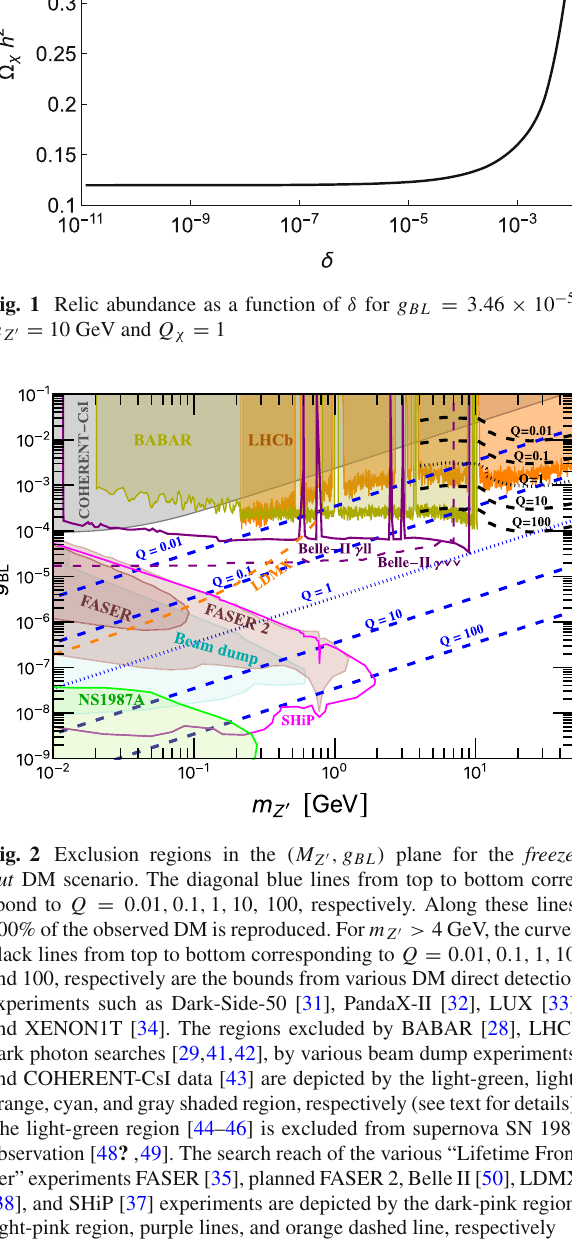
isfied while regions to the right of each of these lines are excluded because they lead to an overabundance of DM. It